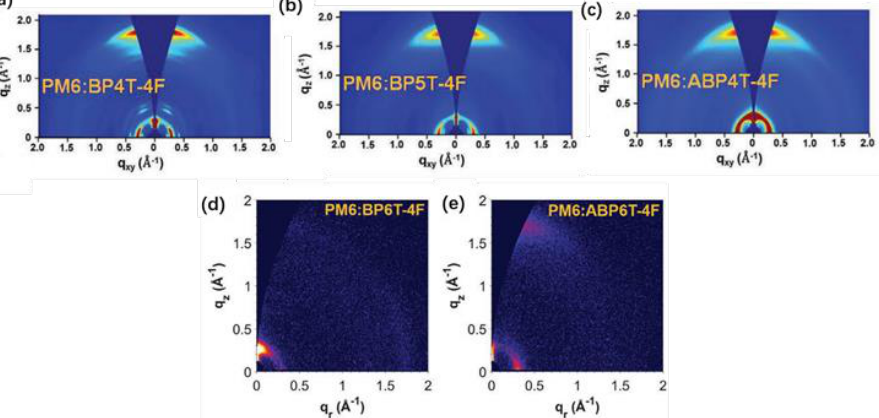
Figure 6. 2D-GIWAXS patterns of PM6 blended with ( a ) BP4T-4F [73] (adapted with permission